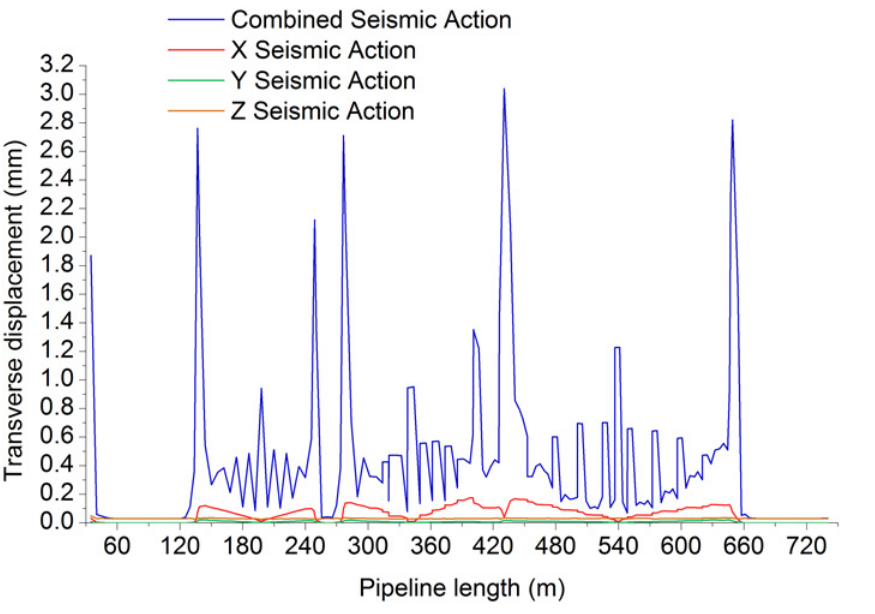
Fig 9. Pipeline transverse displacement during seismic action.